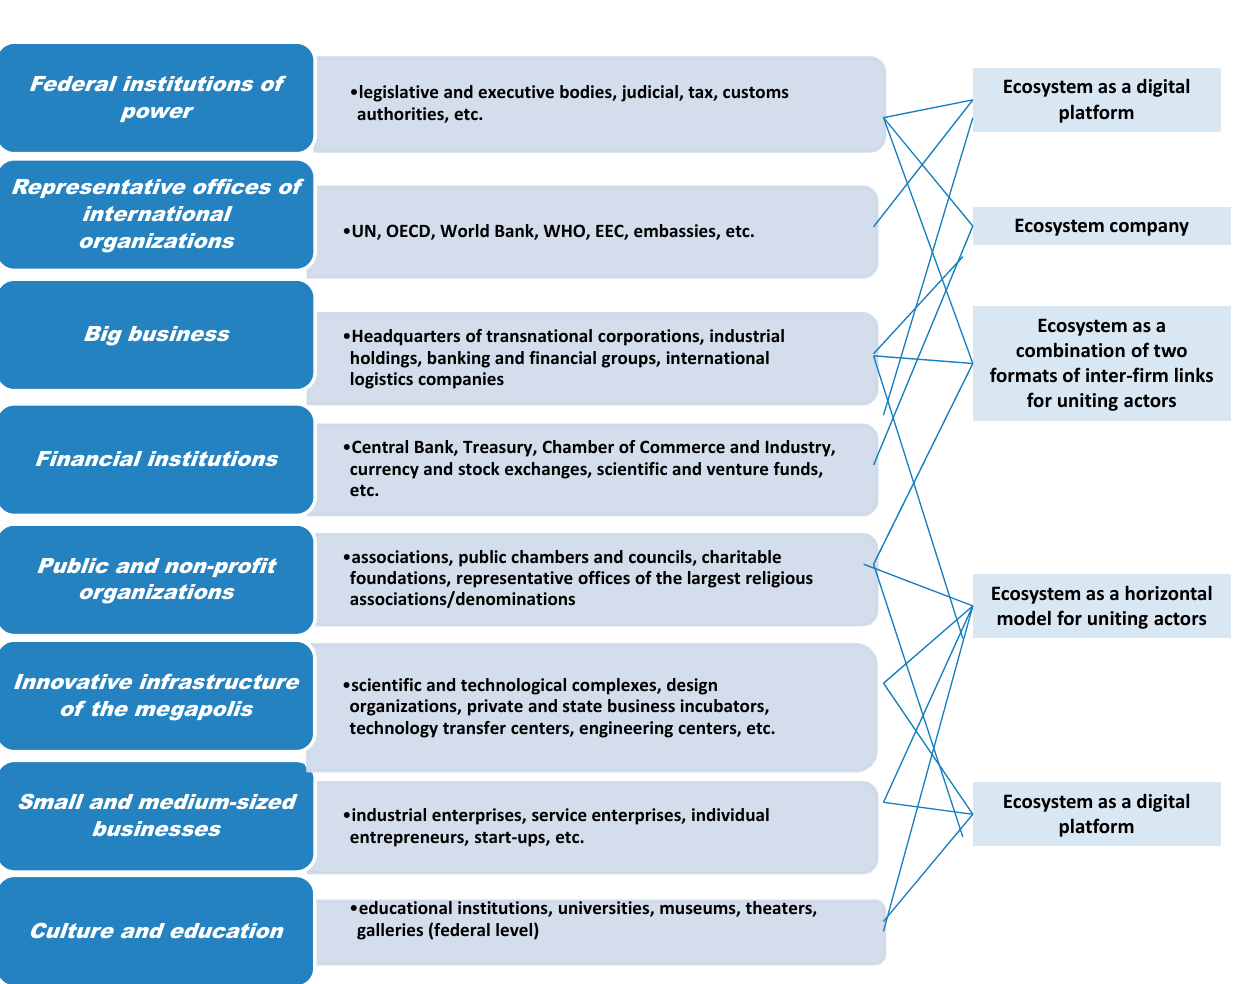
Figure 2. The relationship of the formed ecosystem approaches and the groups of actors in the